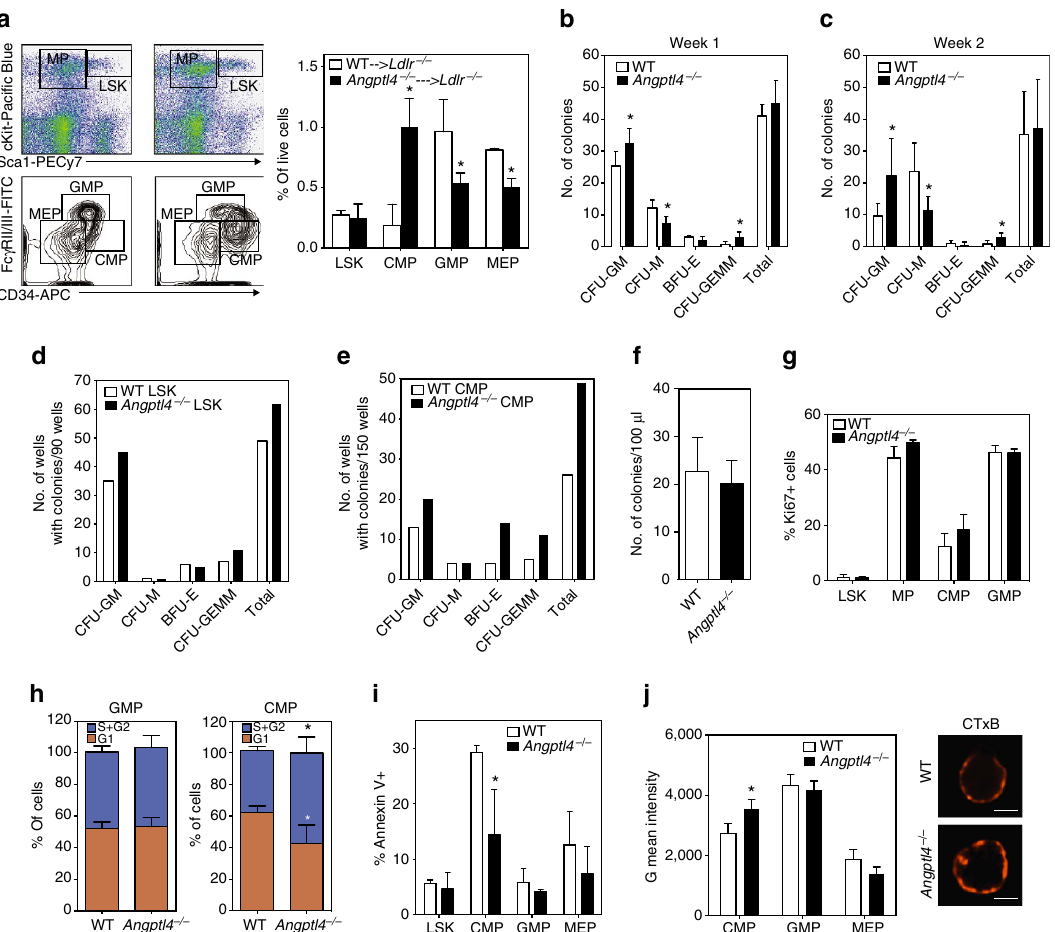
Figure 6 | Haematopoietic ANGPTL4 deficiency promotes CMP expansion. ( a ) Dot plots showing the gating scheme of MP and LSK cells (upper panel), contour plots showing the gating schemes of GMP, CMP and MEP cells (lower panel) in the BM of Ldlr (cid:2) / (cid:2) chimeras with WTor Angptl4 (cid:2) / (cid:2) BM on WD for 12 weeks. Right panel shows the quantification these progenitor populations ( n ¼ 5 per group). Data are mean ± s.e.m. * P o 0.05 by comparison with data from Ldlr (cid:2) / (cid:2) chimeras with WT BM by unpaired t -test. ( b ) Number of colonies from the BM isolated from WT and Angptl4 (cid:2) / (cid:2) mice using CFU assay. Cells were plated in methylcellulose media for 1 week; colonies were counted ( b ), resuspended and plated for 1 more week ( c ) ( n ¼ 6 per group). Number of colony positive wells from LSKs ( d ) and CMPs ( e ) sorted from the BM and plated for 10 days individually in 96 well plates cells in methylcellulose media ( n ¼ 4 per group; a pool of BM was used for sorting from each group). ( f ) Number of colonies from 100 m l blood from WT and Angptl4 (cid:2) / (cid:2) mice plated in methylcellulose media for 10 days ( n ¼ 3 per group). ( g ) Proportion of Ki67-positive proliferating cells from indicated cell type from WTand Angptl4 (cid:2) / (cid:2) BM. ( h ) Cell cycle analysis of GMPs and CMPs from WTand Angptl4 (cid:2) / (cid:2) BM showing fraction of cells in G1 and S/G2 phase as determined by DAPI staining ( n ¼ 5 per group). Cell cycle phase gates were drawn as approximations of the Watson (pragmatic) cell cycle